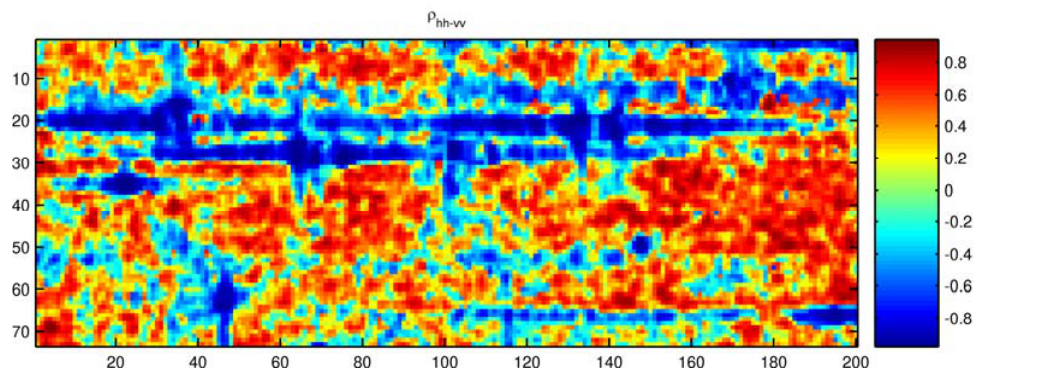
Figure 9. The correlation coefficient of